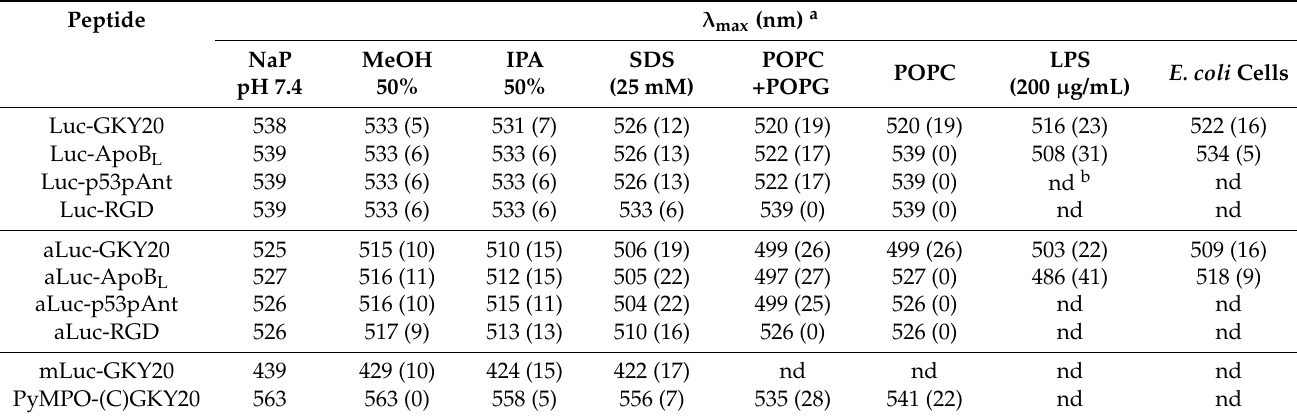
Table 1. λ max and blue-shift values of the labeled peptides.